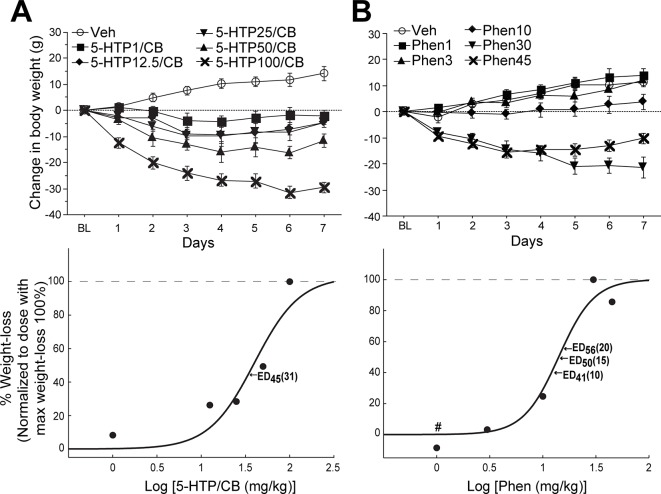
Dose-response curve of 5-hydroxytryptophan (5-HTP)/carbidopa (CB) or phentermine (Phen) alone in rats. (A)
Upper panel: the change in body weight after seven days of intraperitoneal injection of vehicle (Veh) or 5-HTP at different doses 1, 12.5, 25, 50, and 100 mg/kg, pretreated with a fixed dose of CB (75 mg/kg). The horizontal dotted line (at 0 value) represents no weight change relative to BL. Lower panel: Dose-response curve of 5-HTP/CB, from the same data shown in the upper panel. Each dot indicates the average weight loss achieved across seven consecutive days of treatment. The average weight loss was normalized to the dose that induced the maximum weight loss (gray dashed line 100%). Arrows show the computed effective-dose in mg/kg (ED). (B) The change in body weight after Veh or Phen at the following doses of 1, 3, 10, 30, and 45 mg/kg. Symbols represent the mean ± sem. Lower panel: Dose-response curve of Phen alone. Each dot indicates the weight loss induced by the different doses of Phen. Values below 0 indicate doses where weight gain was observed (e.g., see #).